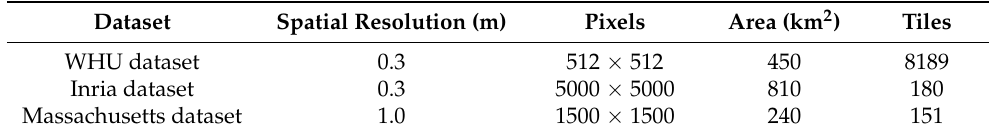
Table 1. Details of each dataset.